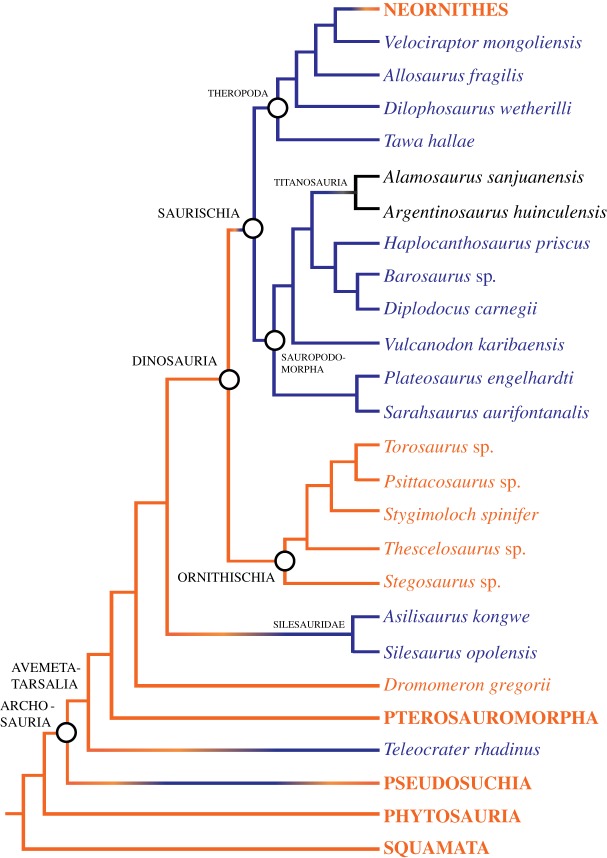
Phylogenetic tree of Avemetatarsalia (from [6,7,31,44,48,54,58,62,63]) with the presence (blue) and absence (orange) of the hyposphene-hypantrum articulation mapped on.